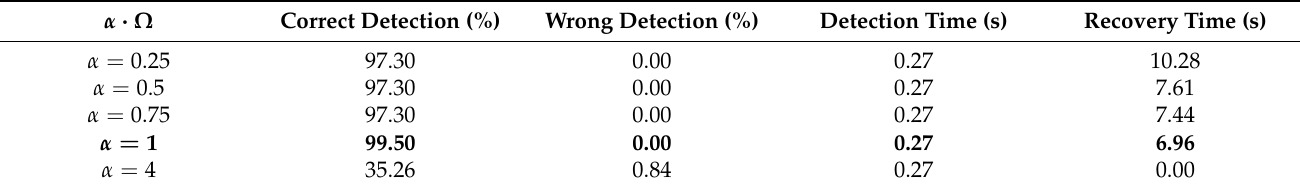
Table 6. Sensitivity analysis for varying of Ω .